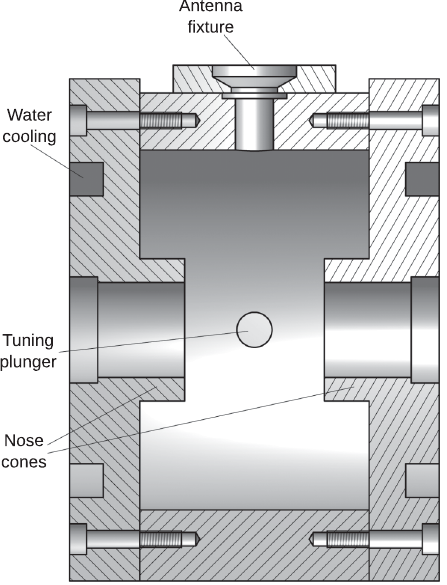
FIG. 3. A cross-section view of the beam current monitoring cavity (created with AUTODESK (cid:1) INVENTOR (cid:1) ).